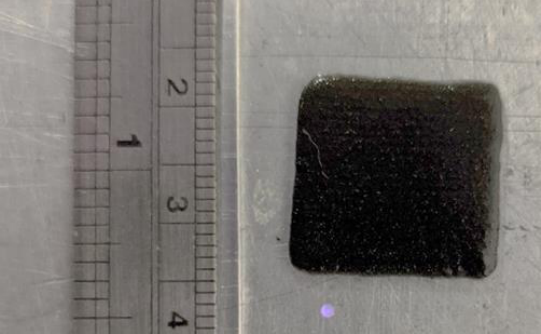
Figure 4. Single material layer deposited using the material-jetting 3D printer.